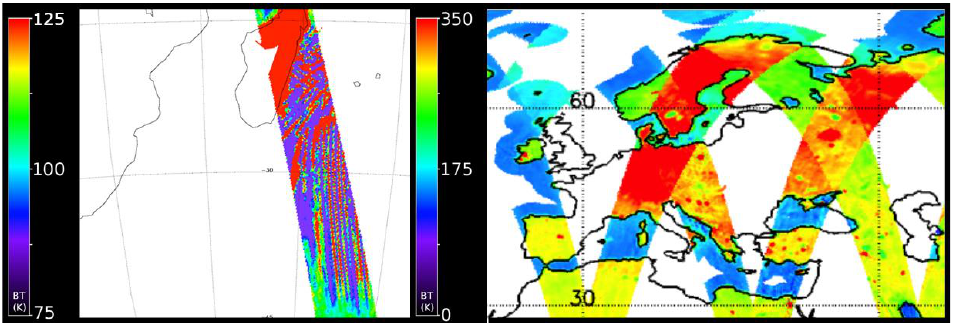
Figure 13. Effects of a very strong source in the Indian Ocean March 2018 ( left ) and another in central Europe September 2017 ( right ).